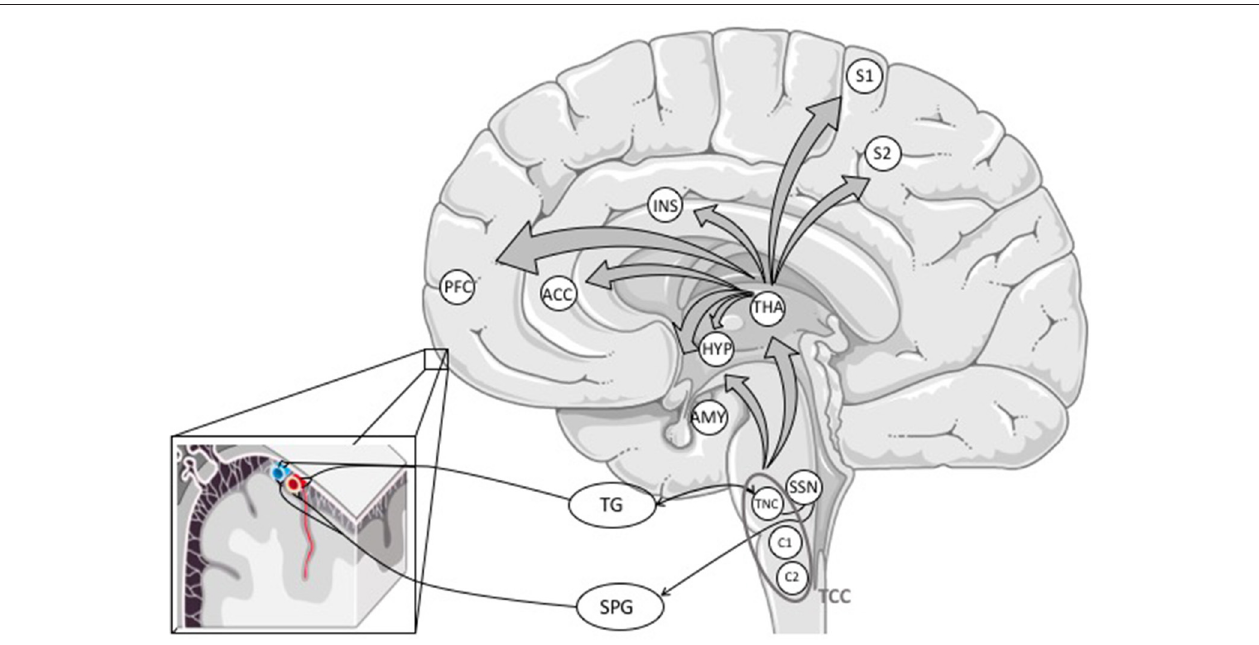
FIGURE 2 | Primary afferents from the meninges and cerebral blood vessels reach the trigeminal ganglion, mostly through the ophthalmic branch (V1). The information is processed via first-order neurons in the TG to second-order neurons in the trigeminal nucleus caudalis forming the trigemino-cervical complex with C1 and C2 dorsal horns of the cervical spinal cord. The TCC projects to different areas in the brainstem (not outlined in this figure) and the thalamus. The activation of the TCC might also activate the trigeminal autonomic reflex. From the thalamus, nociceptive signals are conveyed to (sub-)cortical structures involved in pain perception ( 16). ACC, anterior cingulate cortex; AMY, amygdala; HYP, hypothalamus; INS, insula; PFC, prefrontal cortex; S1 and S2, somatosensory cortex; SPG, sphenopalatine ganglion; SSN, superior salivary nucleus; TCC, trigemino-cervical complex; TG, trigeminal ganglion; THA, thalamus; TNC, trigeminal nucleus